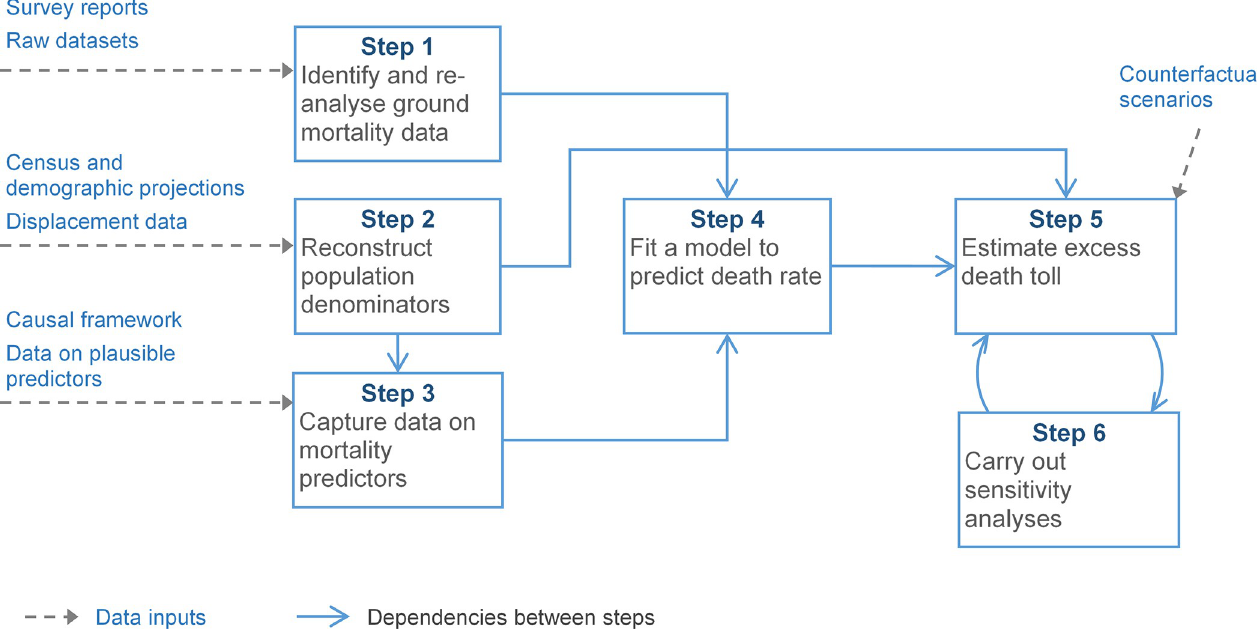
Fig 2. Schematic of estimation steps and required data